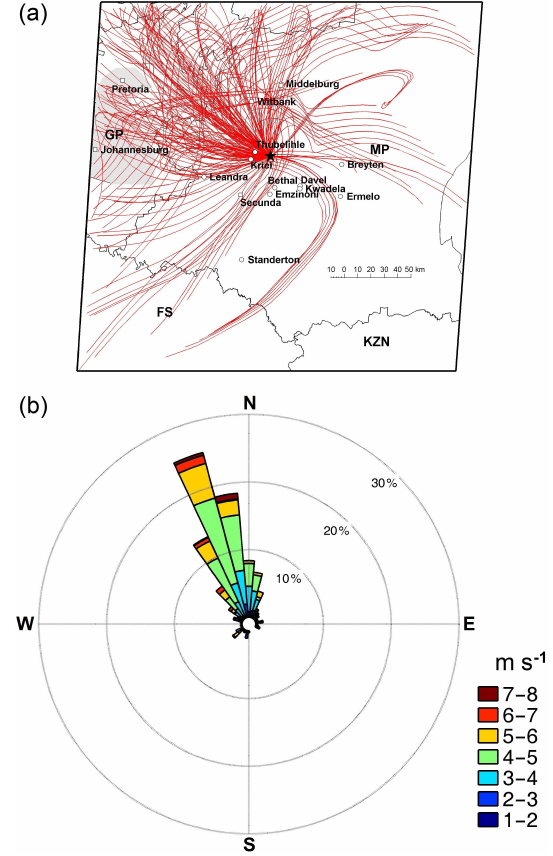
Figure 13. (a) Map indicating 24h back trajectories associated with peaks characterised by coincidental increases in eBC with NO 2 , SO 2 and H 2 S but not NO in June and July. The Elandsfontein site is indicated by the black star. (b) The wind rose associated with arrival times of plumes associated with household combustion is indicated in panel (b)